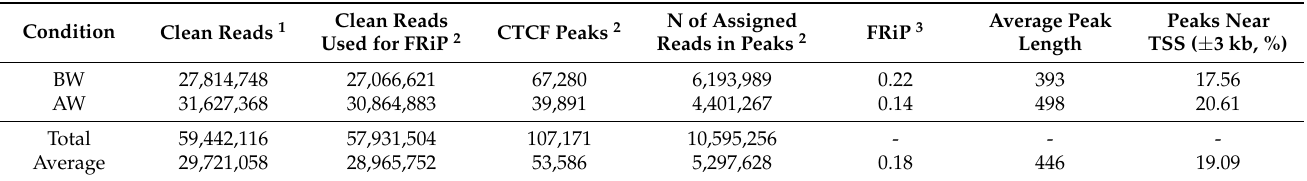
Table 2. Peak calling metrics showing the total number of clean reads used to call peaks and calculate the fraction of reads in peaks (FRiP), number of CTCF peaks (FDR < 0.05), number of assigned reads in peaks, FRiP, an average of peak lengths, and the proportion of peaks near TSS ( ± 3 kb,